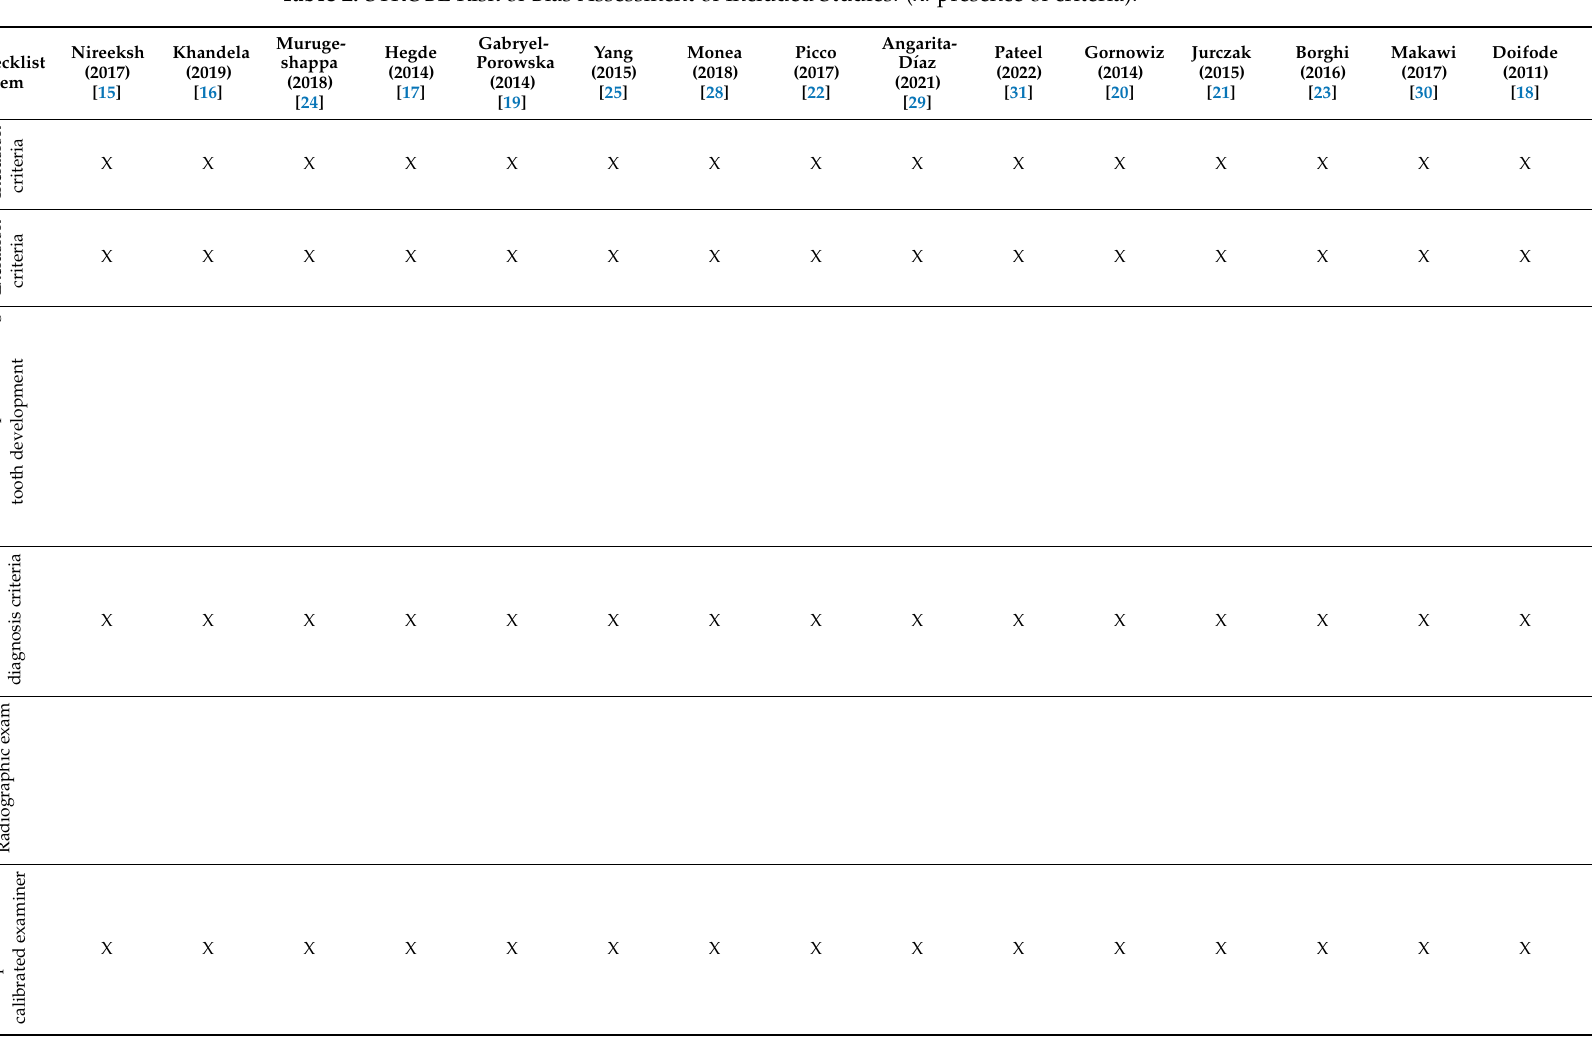
Table 2. STROBE Risk of Bias Assessment of Included Studies. (x: presence of